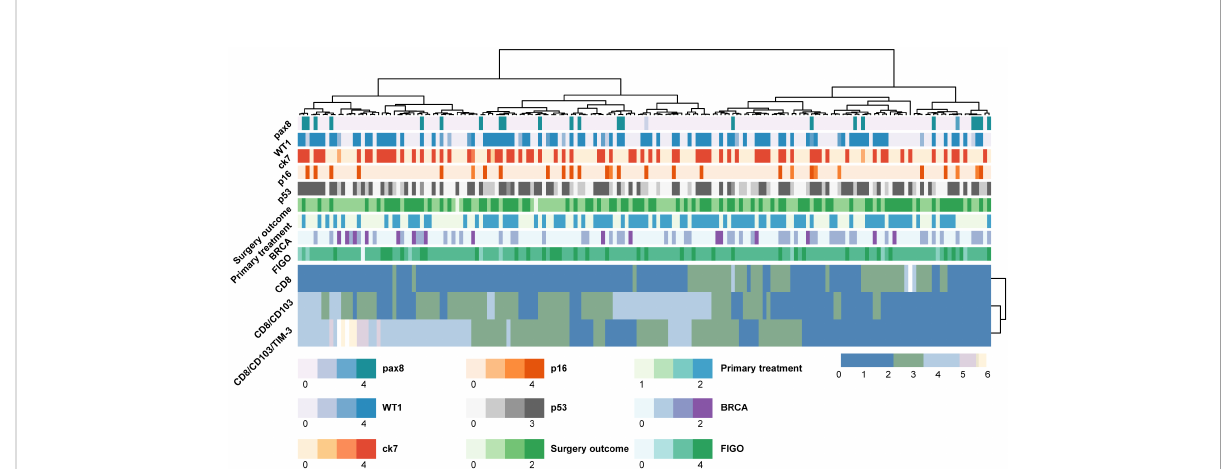
FIGURE 2 Patterns of in fi ltration of CD8/CD103/TIM-3-expressing immune cell subsets. Heatmap displaying in fi ltration of CD8/CD103/TIM-3-expressing immune cell subsets in EOC core samples. Hierarchical cluster analysis of all samples displayed three clusters based on immune cell populations: CD8-positive, CD8/CD103-positive and CD8/CD103/TIM-3-positive. Clinical characteristics are displayed for each sample, including FIGO-stage, BRCA-status, primary treatment strategy (primary debulking surgery (PDS) versus neoadjuvant chemotherapy (NACT)) and the presence of macroscopic disease after surgery (complete versus incomplete). Histopathological markers determined during diagnostic workup including p53, PAX8, WT1 and CK7 are further displayed. Clustering of cases was done by hierarchical clustering using Ward ’ s minimum variance method in R using package pheatmap. Correlations between immune clusters and clinical and histopathological variables were analyzed using multiple regression analysis in